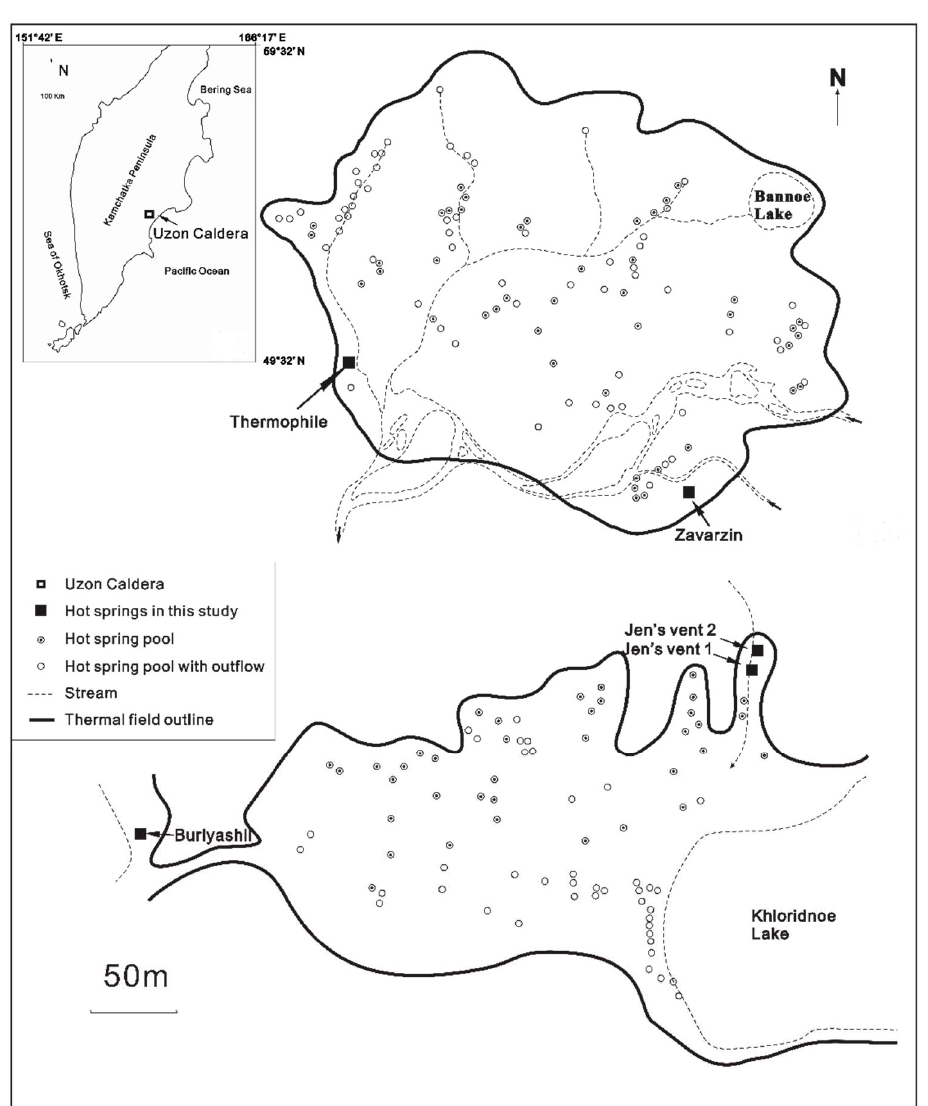
Figure 1. Locations of hot springs in Uzon Caldera, Kamchatka Peninsula (after 56,57).